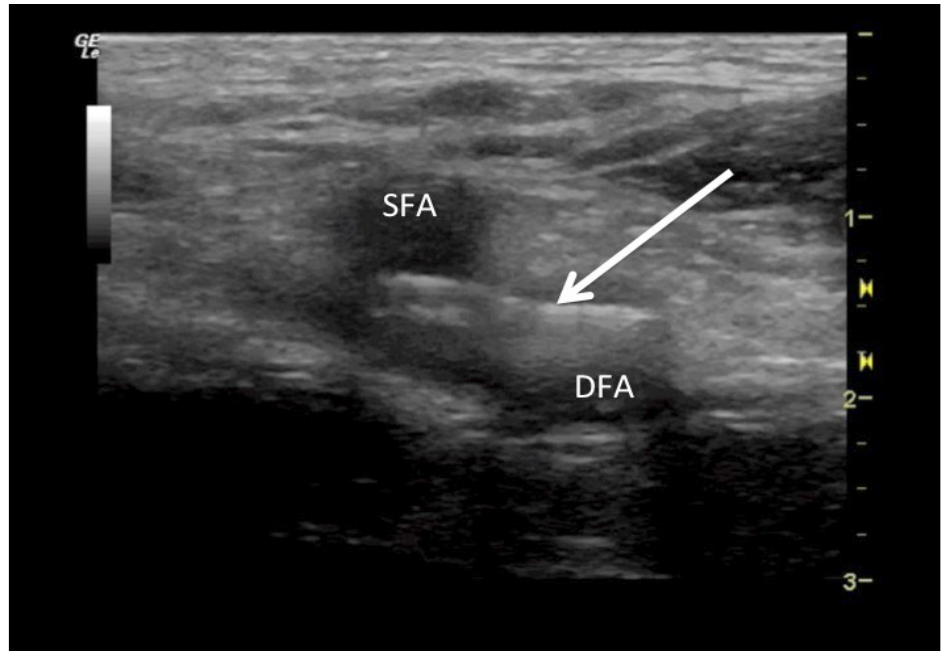
Figure 1. Linear foreign body (arrow) within the femoral artery just distal to the bifurcation of the superficial femoral artery (SFA) and the deep femoral artery (DFA), consistent with retained needle, as seen on point-of-care